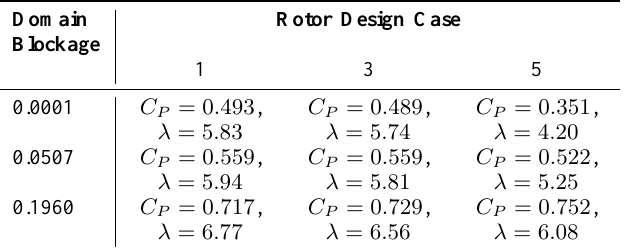
TABLE II M AXIMUM POWER COEFFICIENT AND CORRESPONDING TIP SPEED